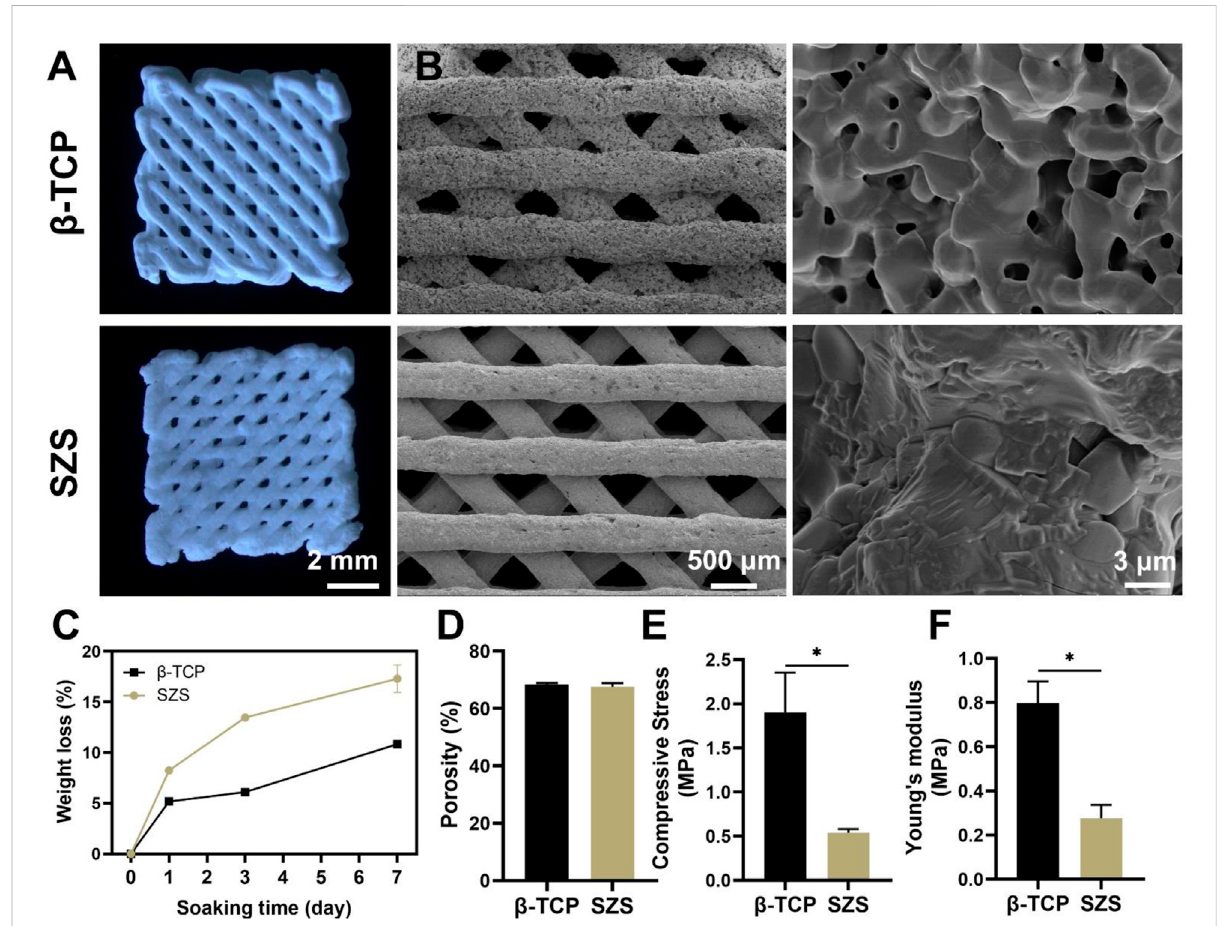
FIGURE 2 Characterizationof3DprintedSZSand β -TCPscaffolds. (A) Optimalimages. (B) SEMcharacterizationofthemacroporousstructureandsurface morphology. (C) In vitro degradationassay. ( n = 3). (D) Porosity ofscaffolds. ( n = 4). (E) Compressive stress and (F) Young ’ smodulus ofscaffolds.( n = 3). * p < 0.05 and ** p <